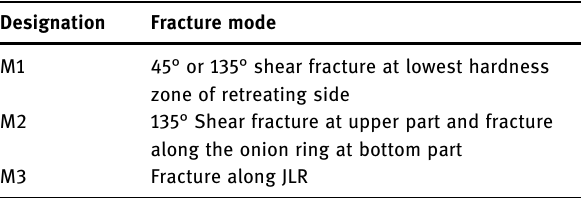
Table 4: Typical fracture